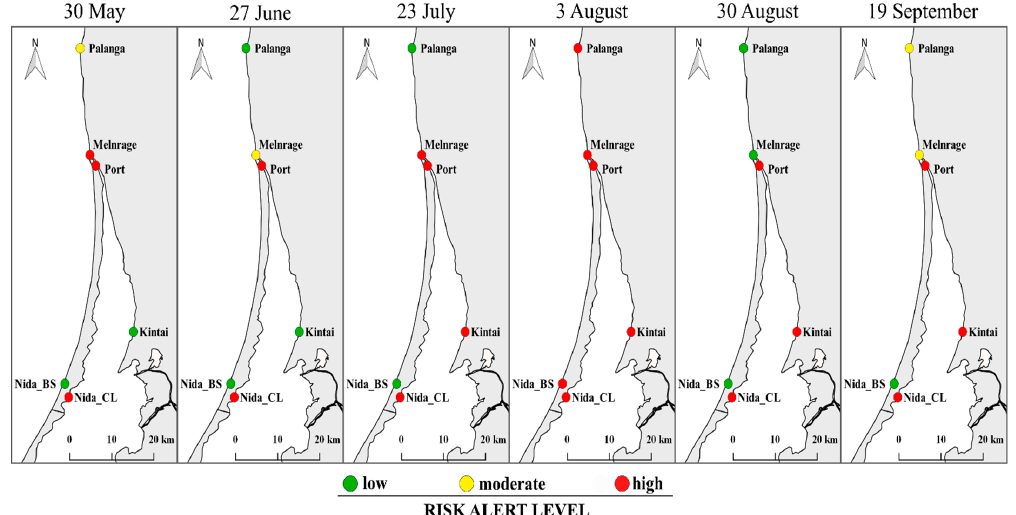
Figure 7. Summary of integrated microbial risk assessment per sampling period of 2018 and study sites along the coast of Lithuania and the Curonian Lagoon. Green dots—’low’, yellow dots—’moderate’, and red dots—’high’ alert level.